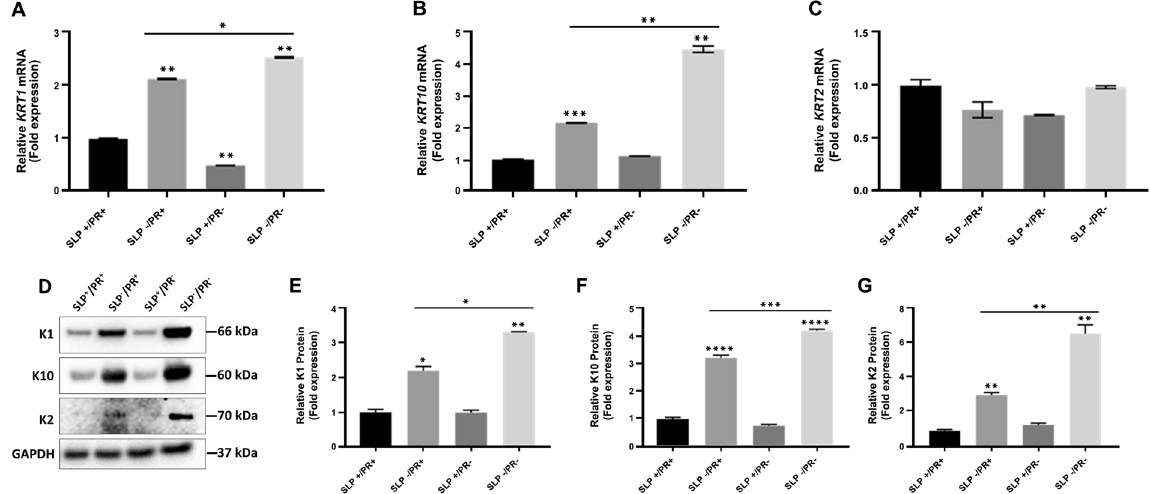
Figure 1. Effect of serum lipids (SLP) and phenol red (PR) on the expression of KRT1 , KRT10 and KRT2 in NHEK cells. NHEK (200,000 cells) were mixed with 10 6 irradiated 3T3 fibroblasts in 2 ml growth medium per well of a 12 well plate for 3 days in four different RM + media conditions, PR containing RM + with or without SLP containing FCS (SLP + /PR + , SLP − /PR + ), no PR in RM + with or without SLP containing FCS (SLP + /PR − , SLP − /PR − ) in triplicates for each growth condition. Feeder cells were removed by squirting PBS/EDTA and keratinocyte lysates were collected and analysed using qPCR and WB. mRNA expression data are shown for different genes ( A ) KRT1 , ( B ) KRT10 and ( C ) KRT2 as fold expression normalised to the expression of two housekeeping genes, POLR2A and YAP1 under different growth conditions. ( D ) NHEK (500,000 cells) were mixed with 1 million irradiated 3T3 fibroblasts in 4 ml growth medium per well of a 6 well plate for 3 days in the above four different RM + media conditions in triplicates for each growth condition. Feeders were removed as above and SDS cell lysate containing 20 µ g total protein (measured by Lowry’s method using BSA as standard) was analysed by western blotting for expression of K1, K2 and K10 under different growth conditions. GAPDH was used as a loading control. Relevant bands were cropped from different blots and grouped together. Original blots are shown in Supplementary Fig. S1. Quantification of protein bands was carried out by Image J and shown for ( E ) K1, ( F ) K10 and ( G ) K2. Statistical analyses: n = 3, Error bars = SEM, Student’s t-test was performed to calculate p values using Microsoft Excel. One-way ANOVA (shown by a horizontal line over the graph) was used to determine the statistical significance in gene expression between different growth conditions. The p values are given by asterisks ( * p < 0.05, ** p < 0.01, *** p < 0.001 and **** p < 0.0001).